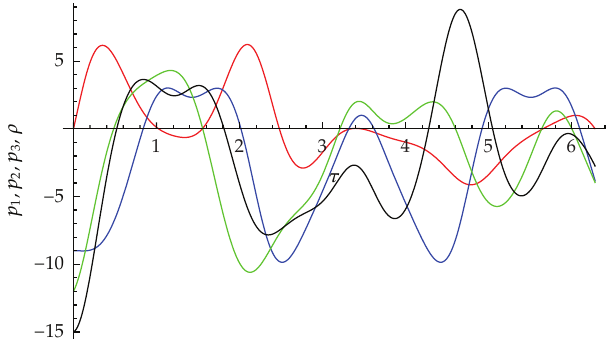
Figure 11: The evolution of p i , ρ for (cid:2) 3.20 (cid:3) , t ∈ (cid:4) 0 , 2 π (cid:5) , k (cid:6) 1 / 3, ρ (cid:2) red (cid:3) , p 1 (cid:2) blue (cid:3) , p 2 (cid:2) green (cid:3) , p 3 (cid:2) black (cid:3) .